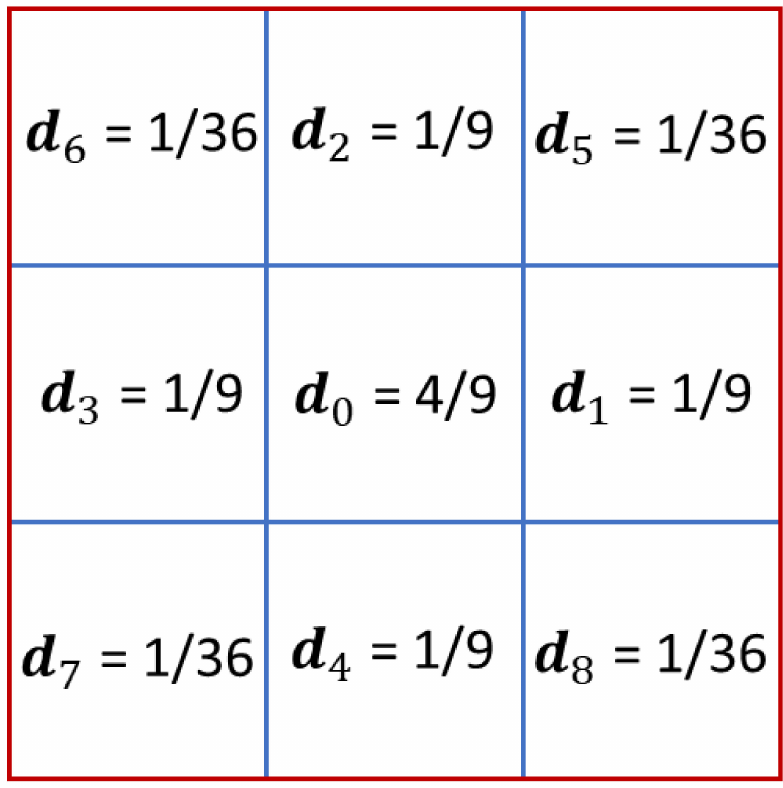
Figure 9. The direction weights for D2Q9